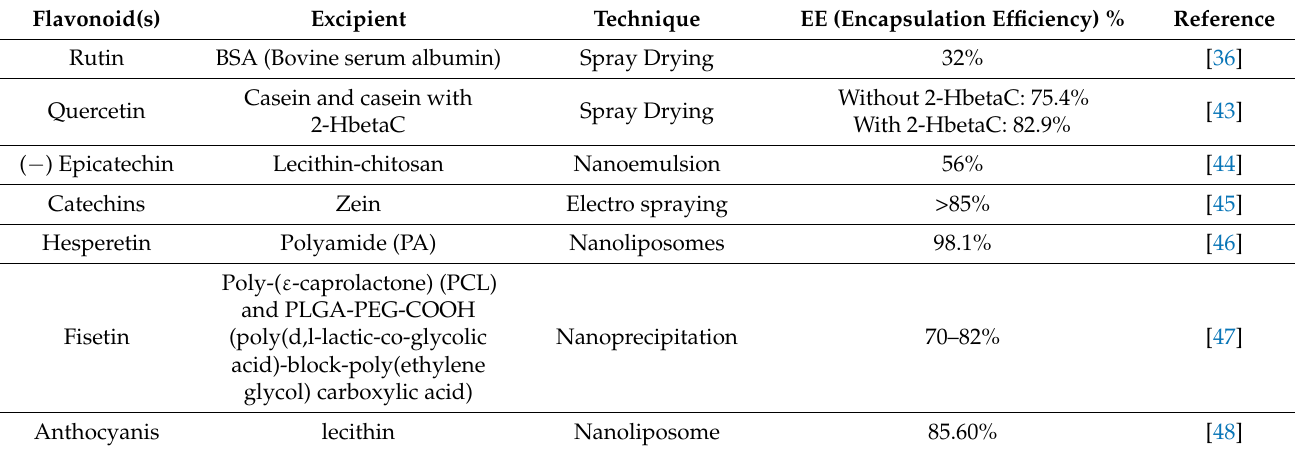
Table 2. Nanoencapsulation techniques of various